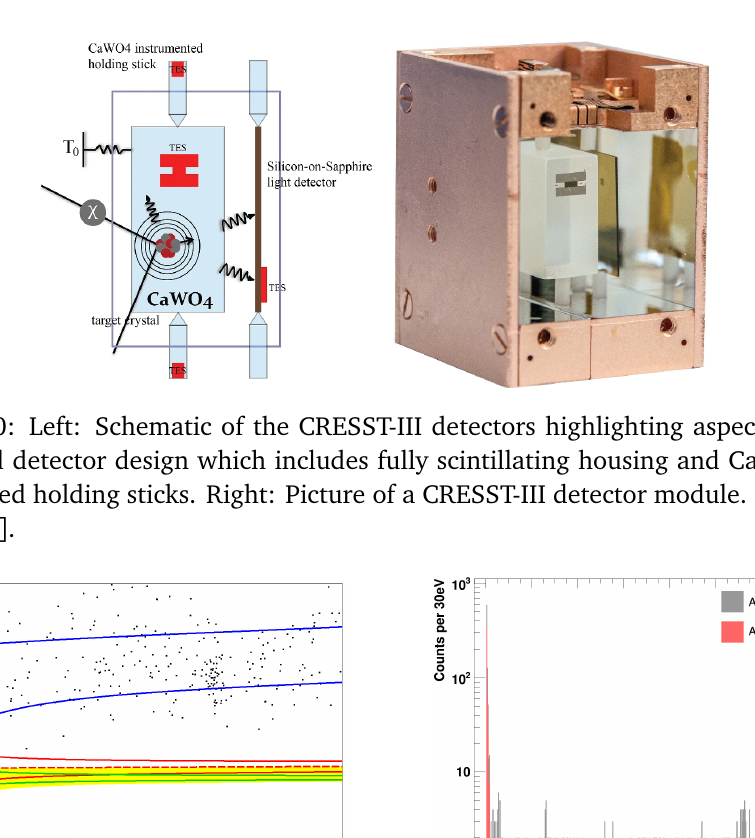
Figure 41: Left: Light yield vs phonon energy for events passing selection criteria in the dark matter data set. The blue lines enclose the 90% C.L. electron recoil band, the red and green lines enclose the 90% C.L. nuclear recoil bands for oxygen and tung- sten, respectively. The yellow band encloses the dark matter candidate acceptance region. All events in this region are taken as dark matter candidates. Right: Energy spectrum of all events passing selection criteria in the dark matter data set. Candi- date events in red fall within the dark matter candidate acceptance region. Adapted from [ 67